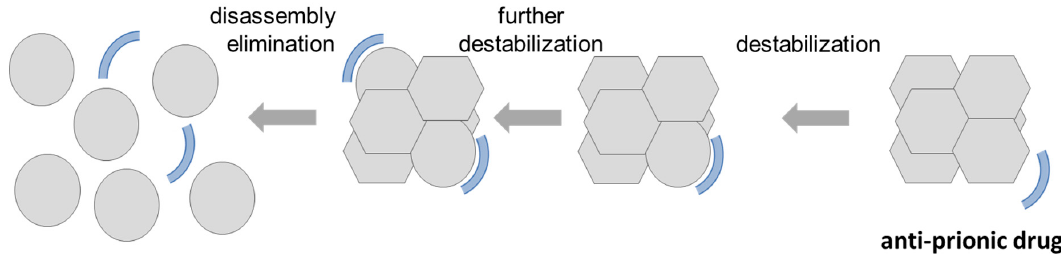
Figure 3. Suggested mode of action of an anti-prionic compound (from right to left): The desired anti-prionic compound should preferentially bind A β monomers and stabilize them in their native, intrinsically disordered conformation. This can be envisioned in a transient manner and is not necessarily in a 1:1 stoichiometry. When the compound is approaching the prion assembly, it will interact with one of the A β monomer subunits and thereby pushing its conformation towards the native one that does not perfectly fit to the rest of the prion particle. Thus, the prion particle is already destabilized a bit by this interaction. Each additional anti-prionic drug molecule will interact with further A β monomer subunits, further destabilizing and ultimately destroying and fully disassembling the A β prion particle. From a physicochemical and biophysical perspective, one would expect the action to be highly cooperative, clearly sub-stoichiometric (relative to the number of A β monomer subunits) and possibly even catalytic, because the drug molecules are not consumed during the prion destruction.